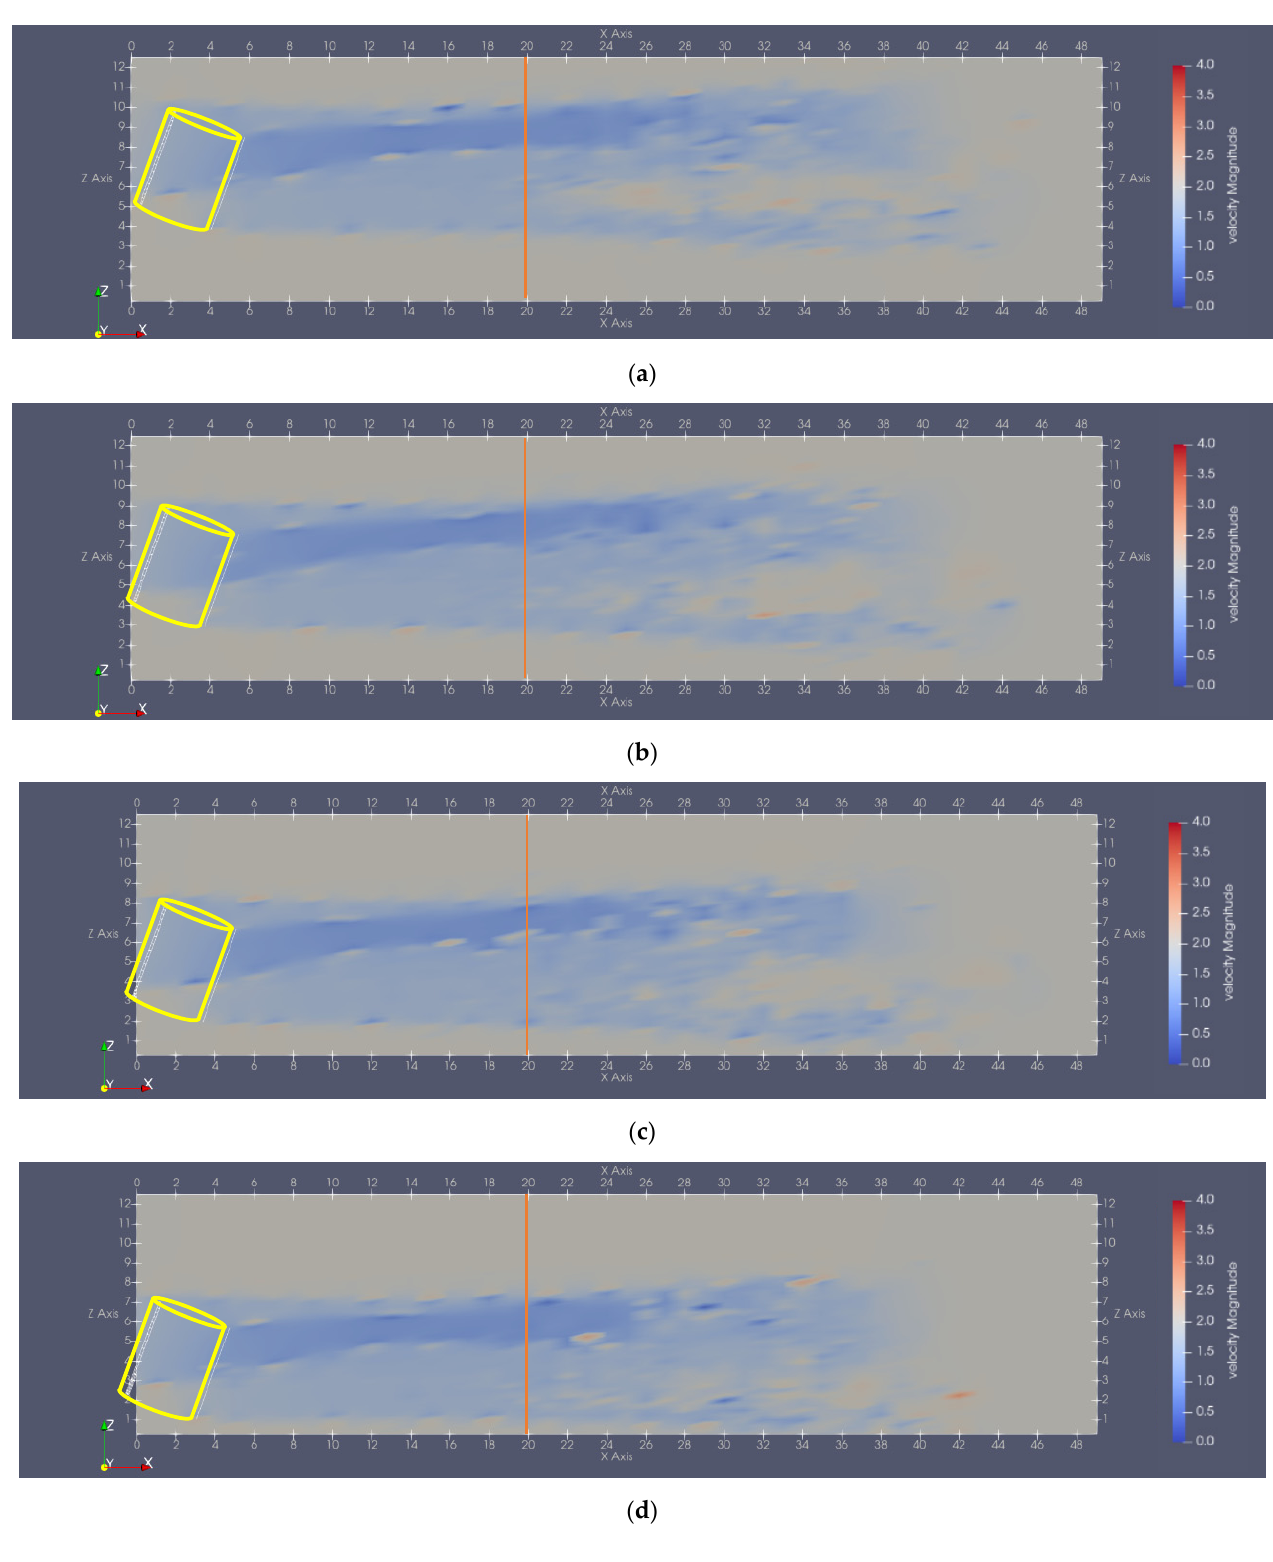
Figure 11. Magnitude of in-plane wind velocity behind a 20-degree-tilted VAWT with different ground clearance: ( a ) 1.0D; ( b ) 0.8D; ( c ) 0.6D; ( d ) 0.4D.